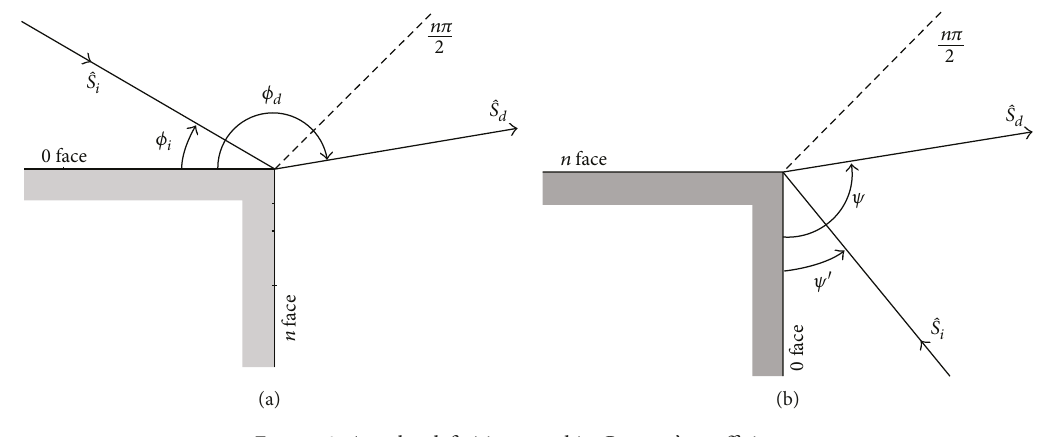
Figure 2: Angular de fi nitions used in Guevara ’ s coe ffi